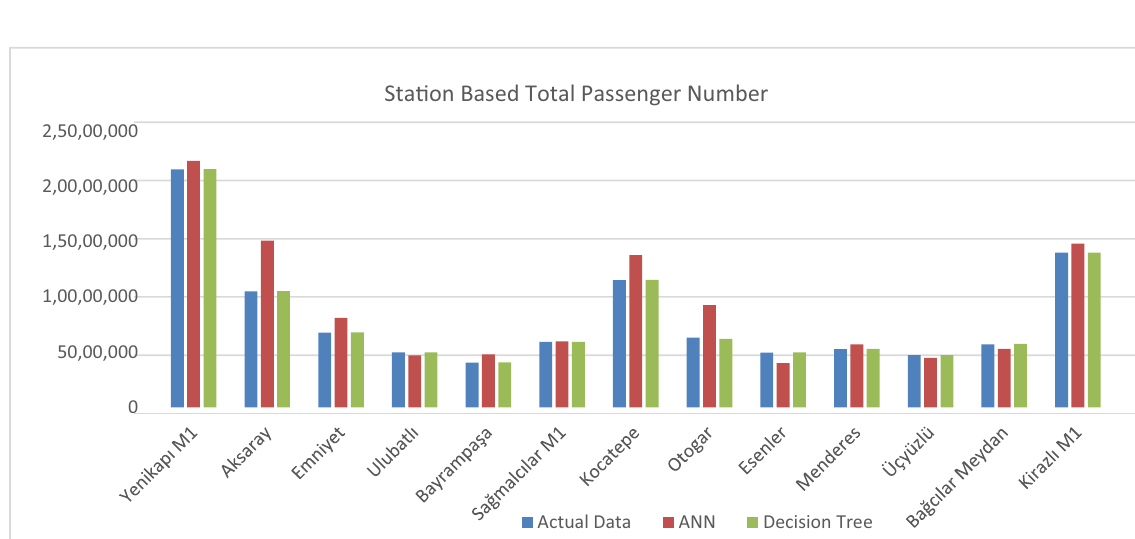
Figure 9: Comparison of demand forecast results with ML algorithms.